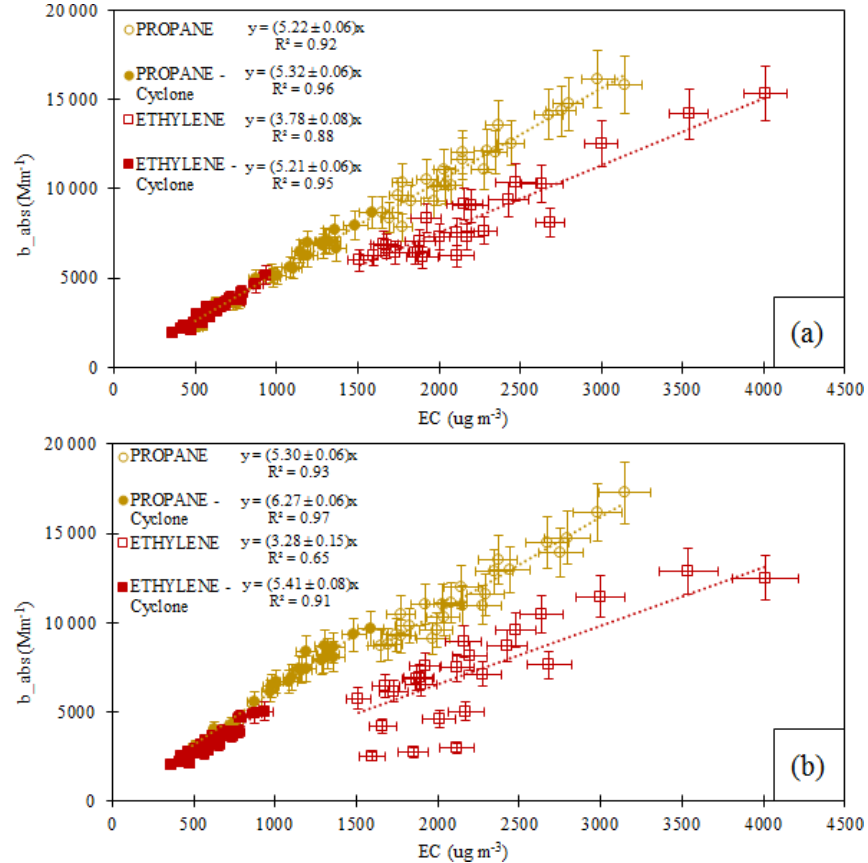
Figure 10. Absorption coefficient at 850nm, measured by MWAA (a) , and at 870nm, measured by PAX (b) vs. EC concentration. The slope of each fit corresponds to the mass absorption